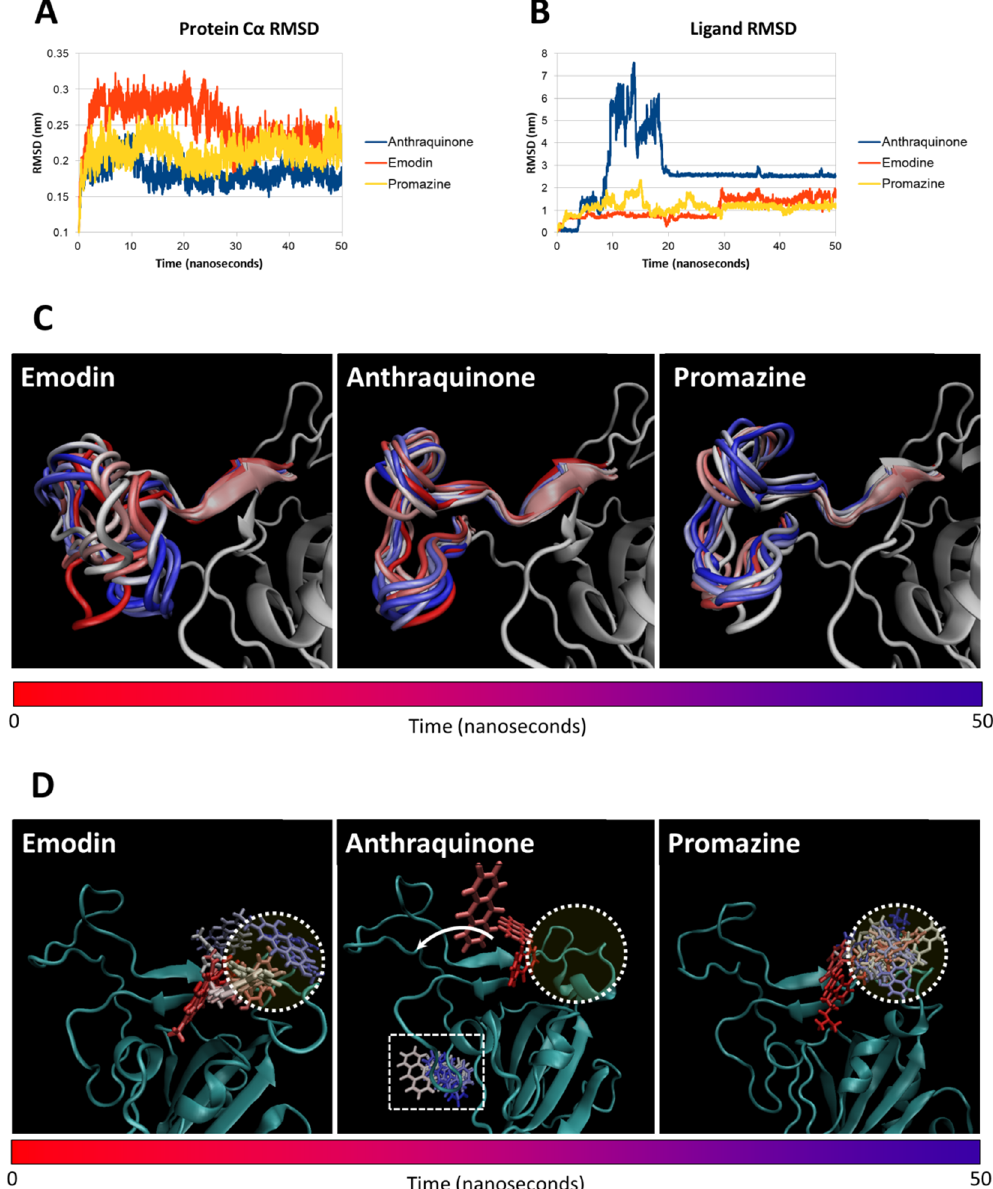
Figure 4. Molecular dynamic of emodin, anthraquinone or promazine in complex with SARS-CoV-1 S protein. ( A ) Root mean square deviation (RMSD) plot of protein C α . ( B ) RSMD plot of ligands. ( C ) Time-step representation of ligands trajectory of localised protein motion (residues 470–490). The switch from red-to-blue color indicates the stepwise changes of protein coordinates along the molecular dynamics (MD) simulation. ( D ) Time-step representation of ligands trajectory. The from-red-to-blue color switch indicates the stepwise changes of ligand coordinates along the MD simulation. The white dotted rings indicate the localization of the hotspot of interaction enriched in protein-protein contacts. The white arrow indicates the outward trajectory of anthraquinone, while the dashed box highlights its late interaction site.